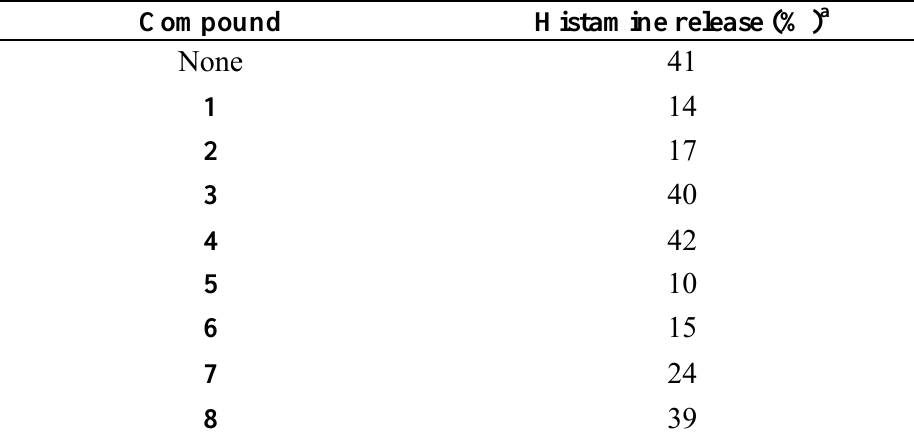
Table 2. Effects of tocopheryl β -glycosides 2 - 4 and 6 - 8 on histamine release from rat peritoneal mast